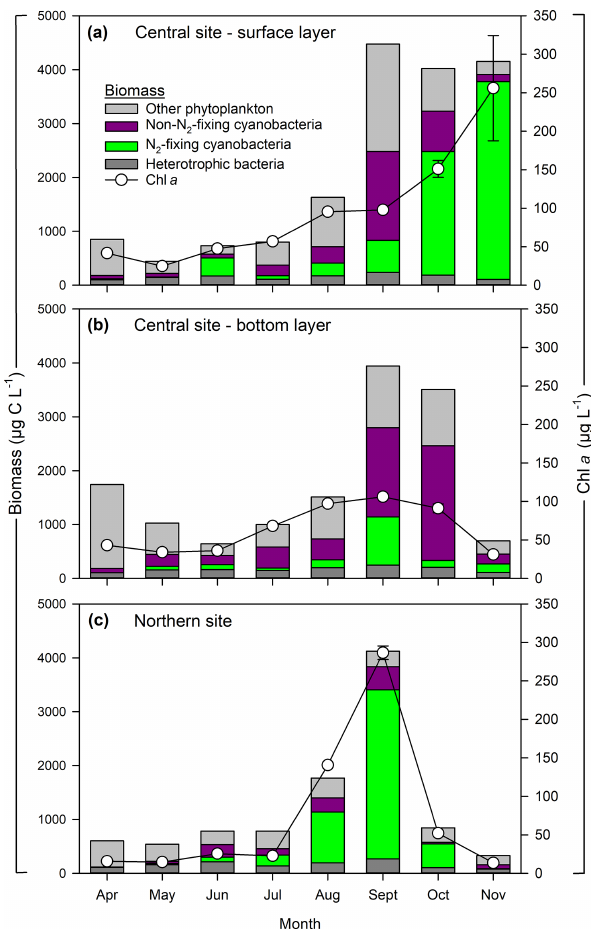
Figure 2. Phytoplankton and heterotrophic bacteria biomass at cen- tral (a, b) and northern (c) sites in the Curonian Lagoon during 2018. Chlorophyll a concentrations are mean values and standard error (some error bars are not visible) based on three